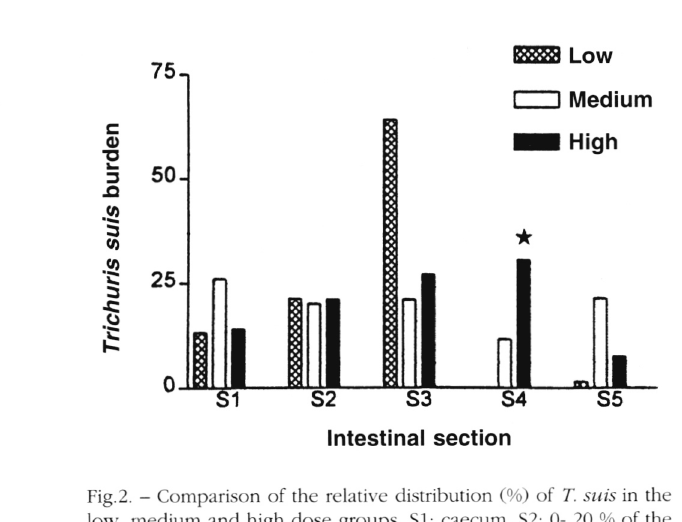
Fig.2. - Comparison of the relative distribution (%) of T. suis in the low, medium and high dose groups. S1: caecum. S2: 0- 20 % of the total length of colon. S3: 21-40 %. S4: 41-60 %. S5: 61-100 % inclu­ ding rectum. The asterisk marks the significantly higher percentage of the worm burden in S4 found in the high compared to the low dose group ( P = 0.026).